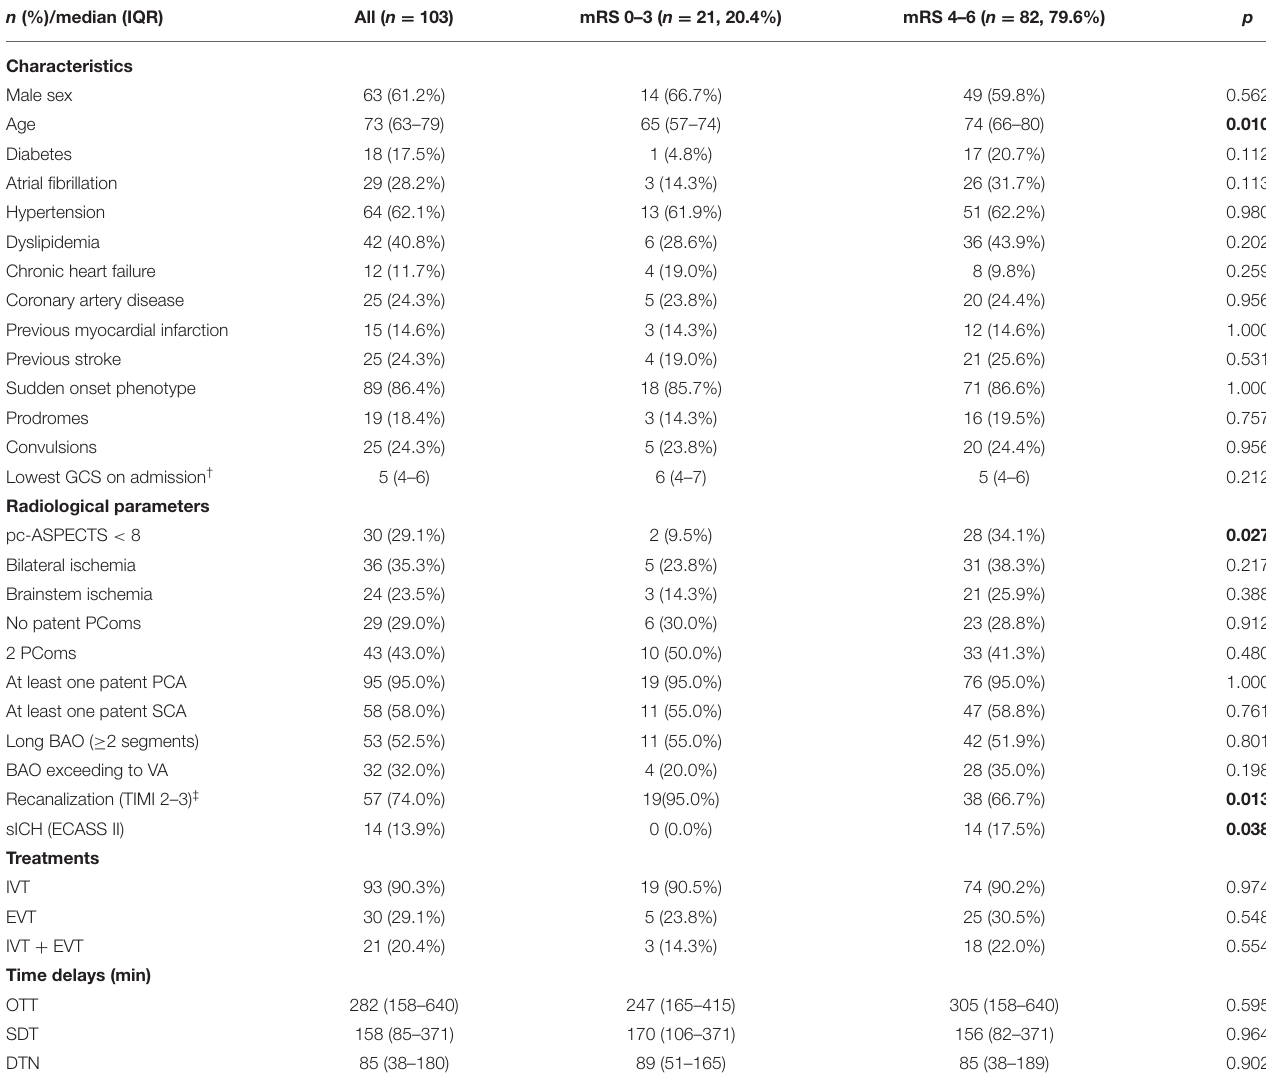
TABLE 4 | Characteristics associated with favorable outcome in comatose BAO patients. n (%)/median